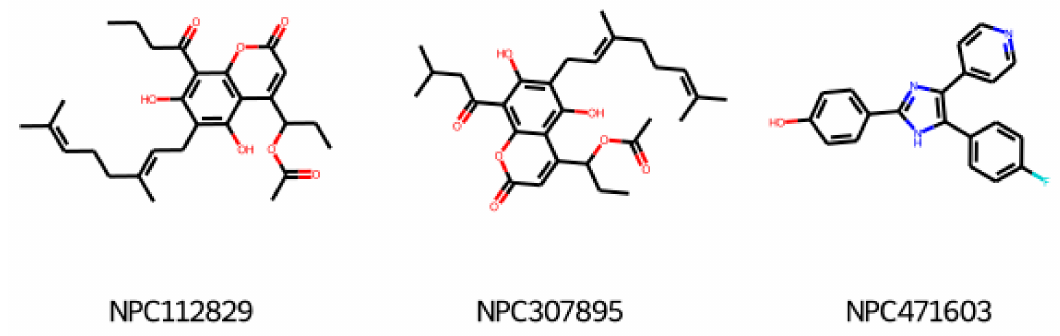
Figure 8. Top compounds found by the GCGR model in the CMAUP subset for Mammea siamensis . One of these compounds (right) was also suggested in CMAUP as GCGR active (80